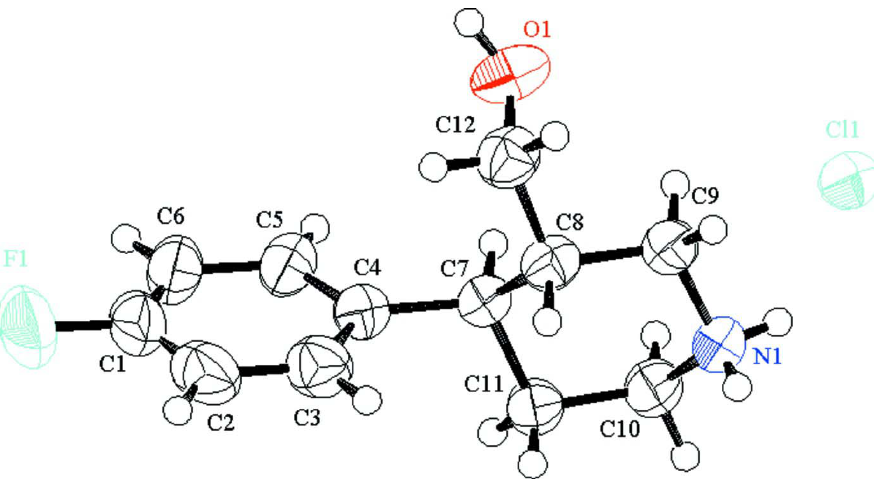
Figure 1 Molecular structure of (I) showing the atom numbering scheme. The displacement ellipsoids are drawn at the 50% probability level. H-atoms are shown by small circles of arbitrary